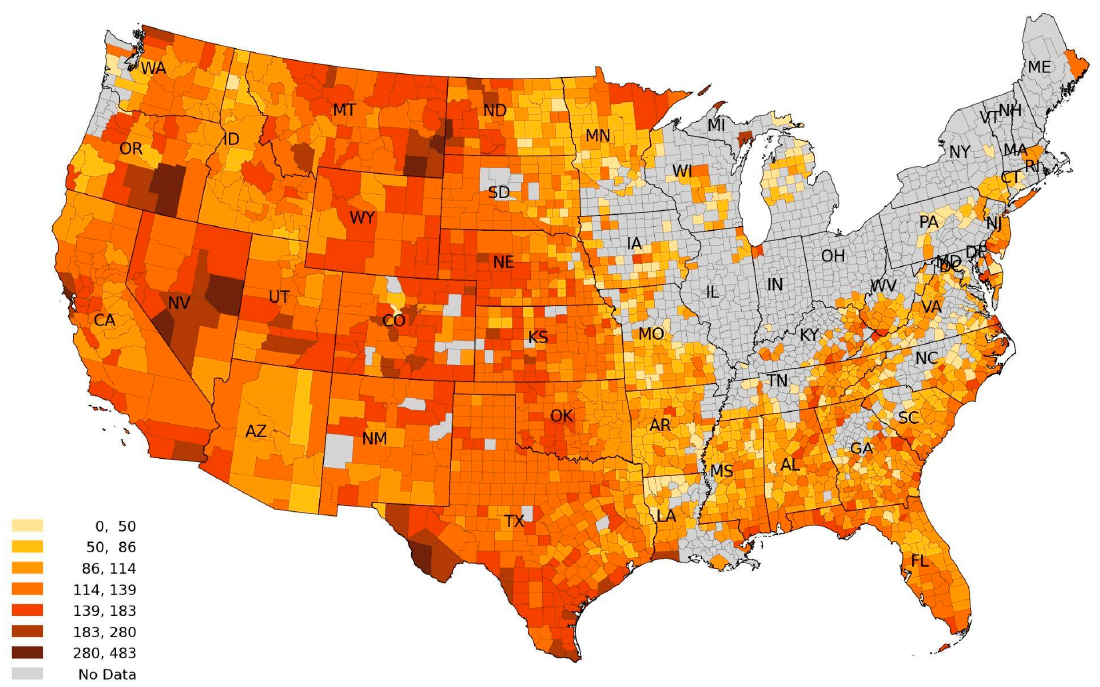
Figure 13. Percent Increase in annual likelihood of wildfire exposure among properties with at least 0.03% annual likelihood of wildfire exposure.